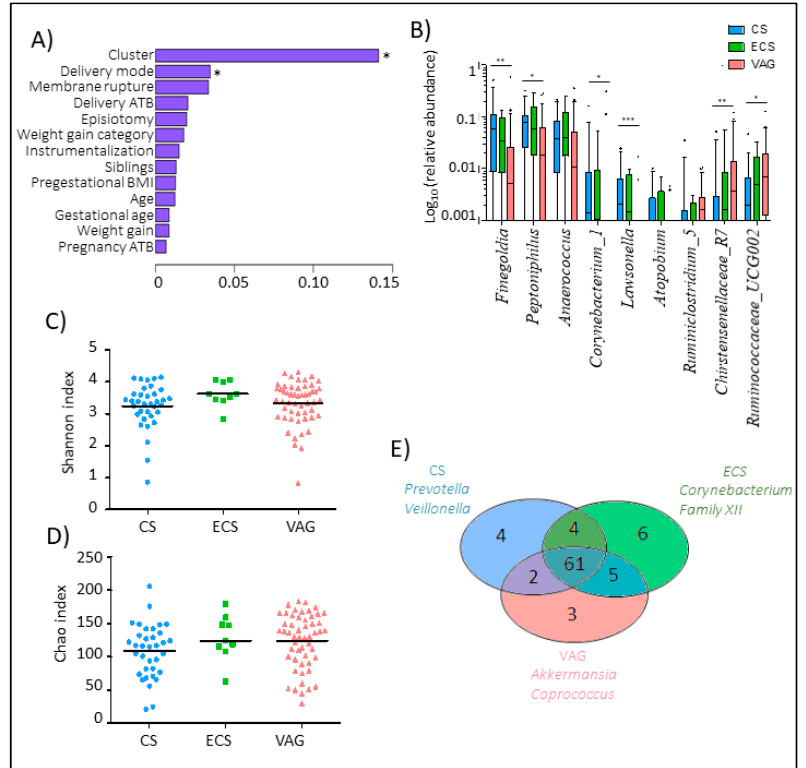
Figure 2. Maternal microbiota composition is influenced by the delivery mode. ( A ) Multivariate analysis of the effect of the studied perinatal factors on the maternal microbiota composition at delivery based on Bray-Curtis. Membrane rupture. antibiotic at delivery, and episiotomy were only studied in mothers who had vaginal delivery. ( B ) Boxplot of the main genera that marked the difference of the maternal microbiota composition between delivery modes. Data was transformed by log10 of the relative abundance of each genus for plotting. Whiskers represent the 5–95 percentile interval. ( C ) The core group of the maternal microbiota composition at the genus level performed by the Venn diagram. ( D , E ) Differences in the diversity ( D ) and richness ( E ) of maternal microbiota based on the Shannon index according to the delivery mode. The line represents the median of each group. CS (Elective C-section). ECS (Emergency C-section). VAG (Vaginal delivery). * p < 0.05. ** p < 0.01. *** p < 0.001.